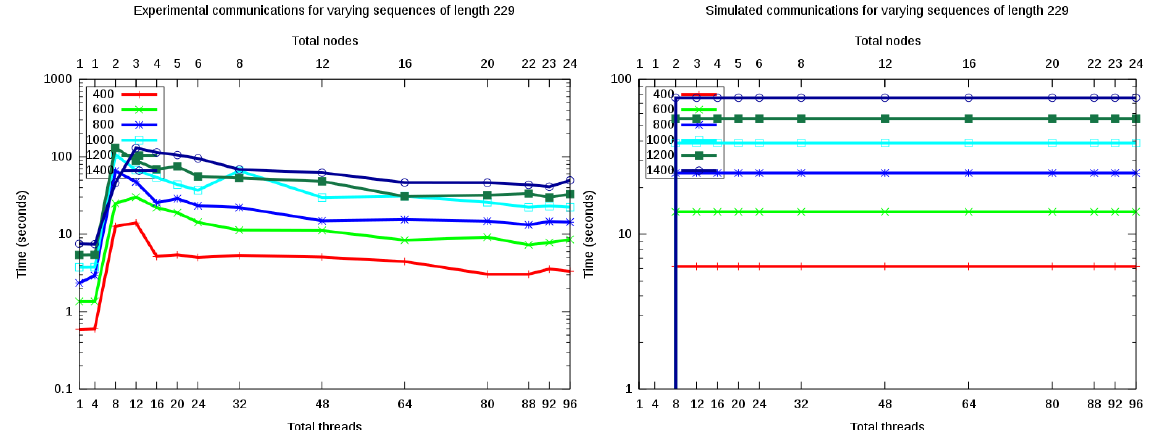
Figure 8: Communications overhead varying the number of sequences.